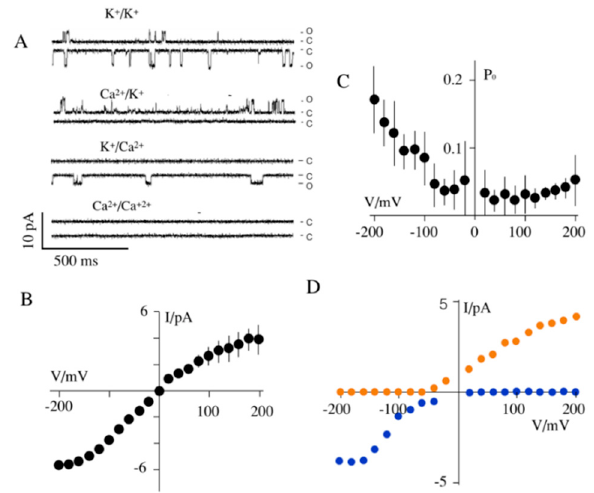
Figure 2. Kmpv 12T is a functional K + channel but Kesv is not. ( A ) Exemplary single channel fluctuations of Kmpv 12T in a phosphatidylcholine bilayer. Channel fluctuations between the closed (c) and open (o) level at ± 120 mV were recorded in solution with symmetrical 100 mM KCl (K + /K + ), symmetrical 100 mM CaCl 2 (Ca 2+ /Ca 2+ ) as well as with 100 mM KCl/CaCl 2 on cis/trans (Ca 2+ /K + ) or trans/cis (K + /Ca 2+ ) side. Mean single channel current/voltage (I/V) relations ( B ) and open probability/voltage relation (P 0 /V) ( C ) from measurement in symmetrical 100 mM K + . ( D ) I/V relation from measurements with 100 mM KCl/CaCl 2 on cis/trans (blue) or trans/cis (orange).